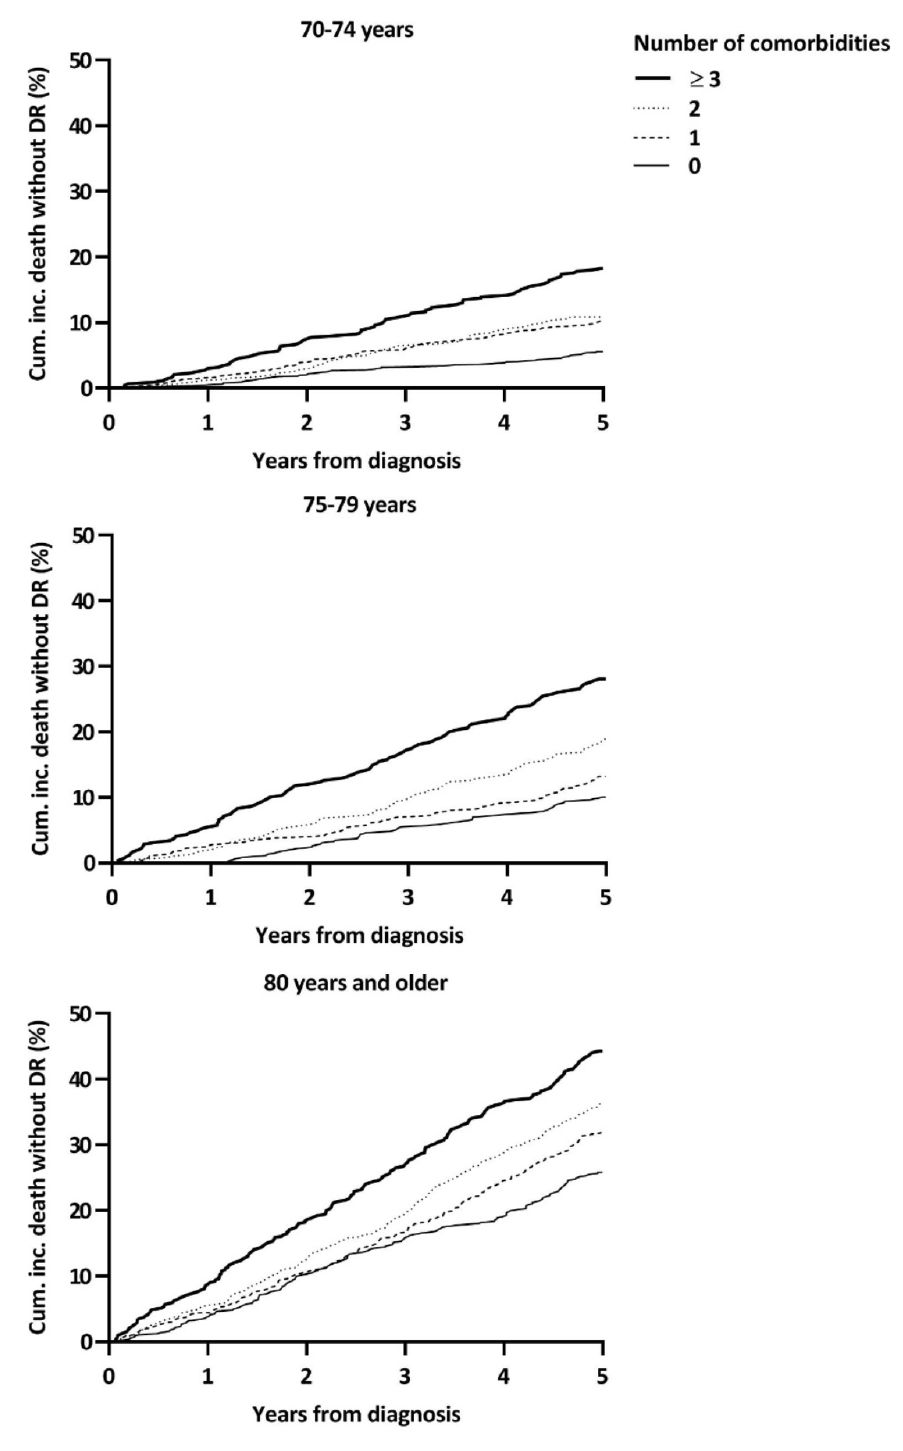
Figure 4. Cumulative incidences of other-cause mortality by age and number of comorbidities.